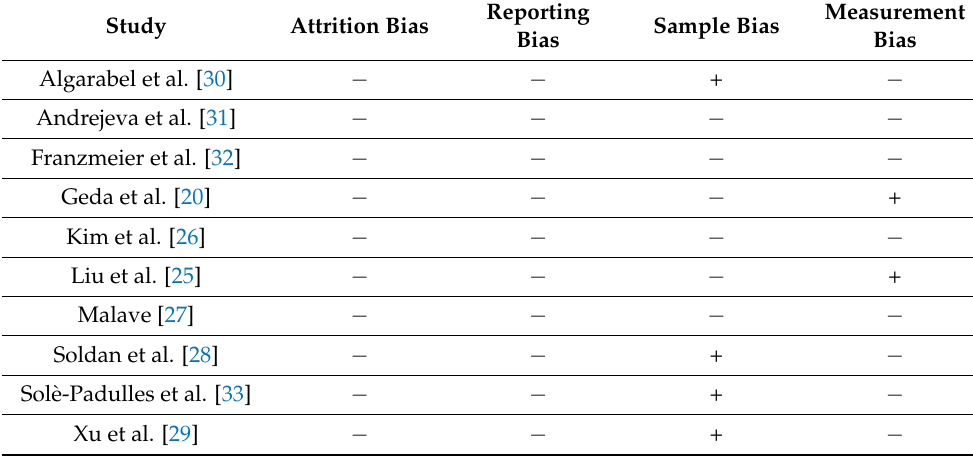
Table 2. Risk of